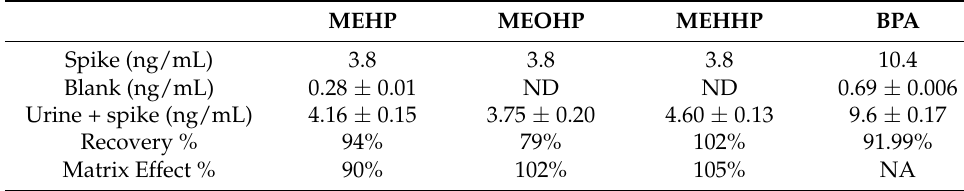
Table 3. Recovery of DEHP metabolites and BPA in blank and urine samples.